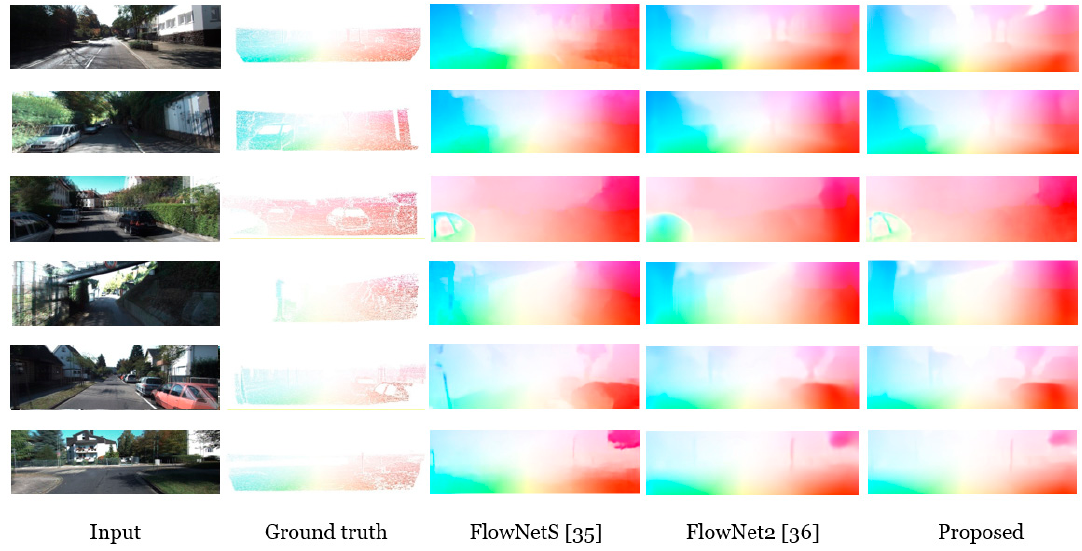
Figure 6. Visual optical flow evaluation results. Our networks are tested on KITTI flow 2012 and KITTI flow 2015. As shown in the flow estimation results, the proposed method clearly estimates the occluded and homogeneous flow values.